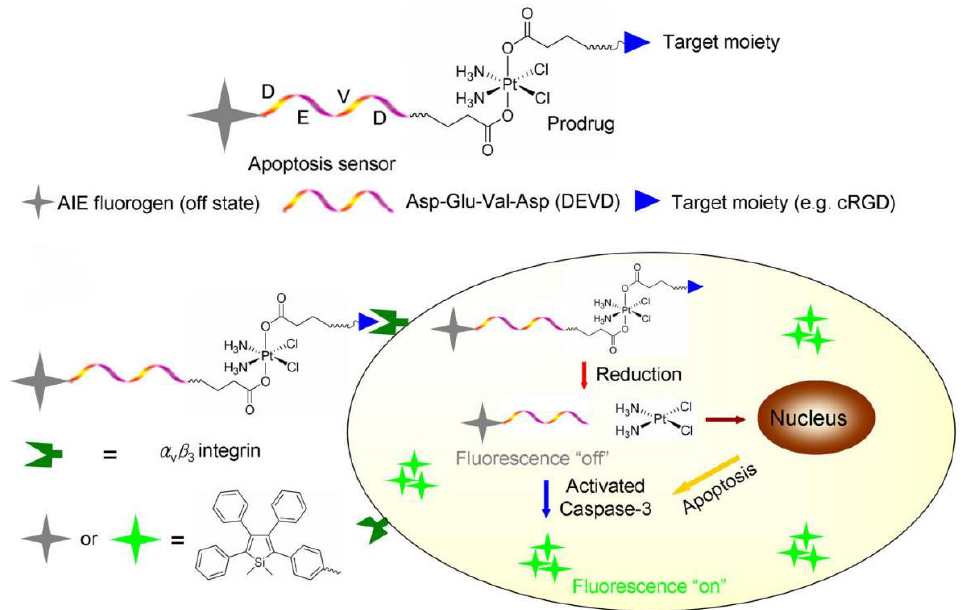
Figure 7. Scheme depicting the structure of the Pt(IV) prodrug with a built-in apoptosis probe and its working mechanism of the early determination of its therapeutic effect in situ. Reprinted/adapted with permission from [53]. Copyright 2014, American Chemical Society.